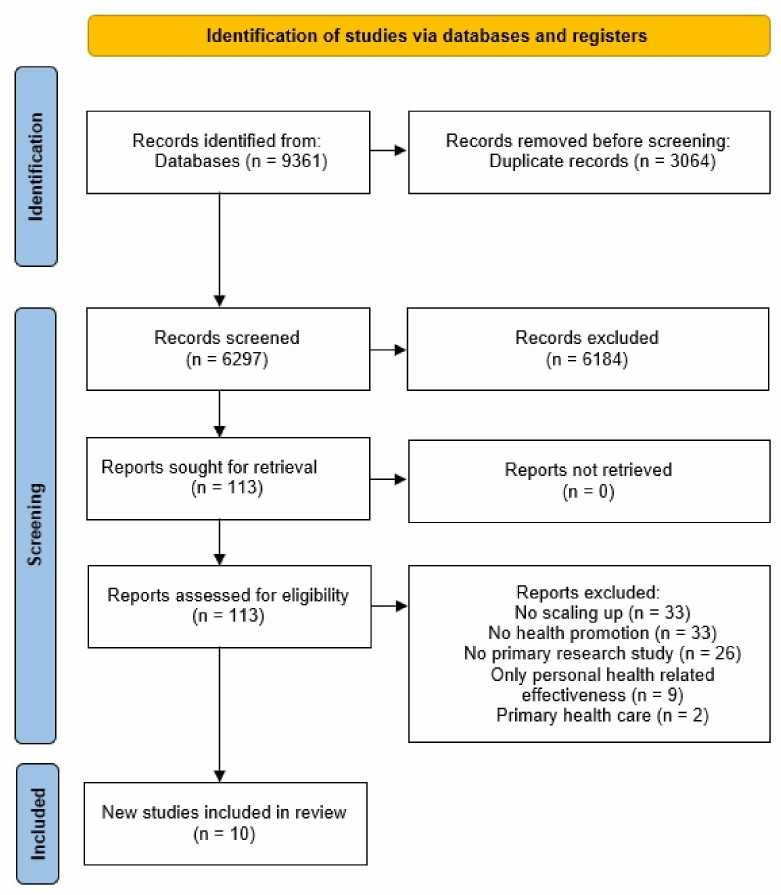
Figure 2. PRISMA flow diagram of the search for primary research studies. Table 2. Characteristics of the identified primary research studies. None were identified by gray literature